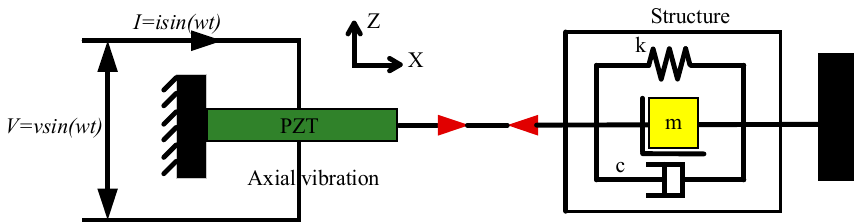
Figure 2. One-dimensional model of lead zirconate titanate (PZT)—structure dynamic interaction.